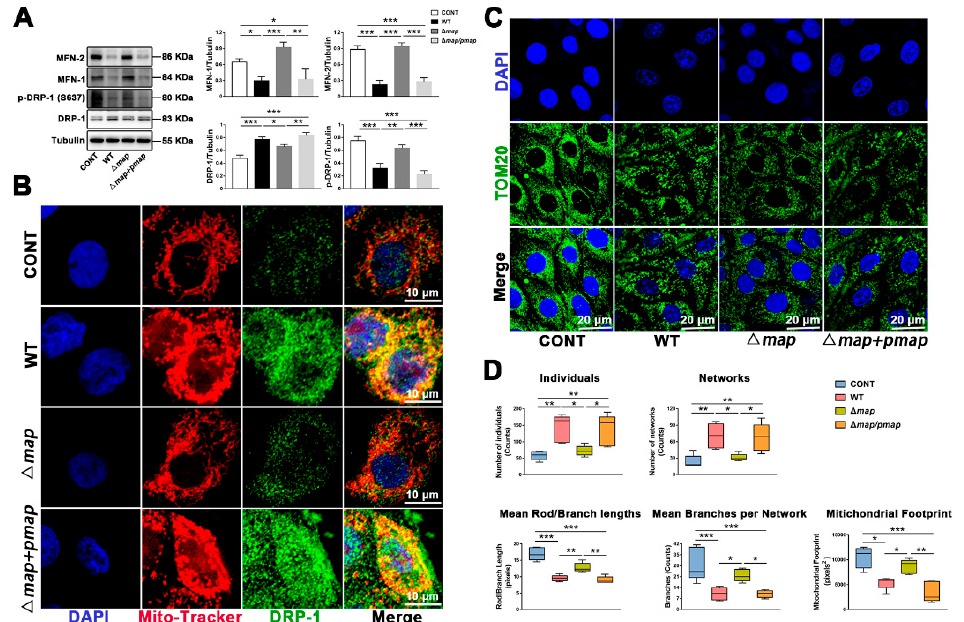
Figure 4. E. coli (EPEC)-Map induces mitochondrial fragmentation. ( A ) The DRP-1, p-DRP-1 (ser637), MFN-1, and MFN-2 levels were analyzed by Western blot. ( B ) DRP-1 translocated to the mitochondria. The cells were stained with anti-DRP-1 (green), mitochondria (Mito-Tracker, red), and DAPI (blue, nucleus). Scale bar, 10 µ m. ( C ) Mitochondrial morphology was stained with anti-TOM20 (green) antibody. DAPI (blue, nucleus); scale bar, 20 µ m. ( D ) FIJI software was used to analyze the related indexes of the mitochondrial network structure. MAC-T cells were washed with PBS (3 times) to remove antibiotics and exposed to WT, ∆ map , and ∆ map + pmap strains for 8 h (MOI of all strains = 66). Representative images are shown. Data are from 3 independent experiments and presented as the mean ± SEM; * p < 0.05, ** p < 0.01 *** p <